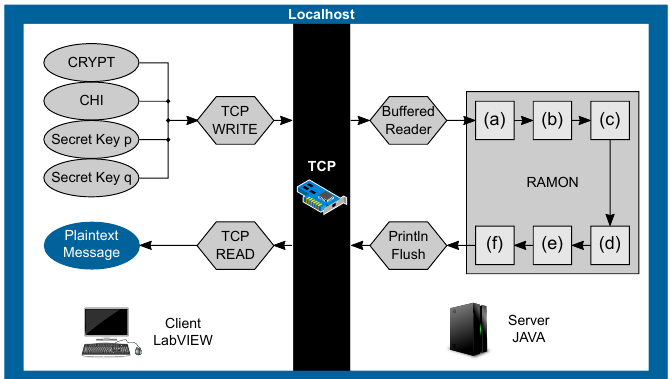
Figure 5. Flow chart of the time-optimized decryption using a TCP/IP connection to interact between LabVIEW and the Java application. CHI, the secret keys p and q and the crypt c ∗ are transferred from LabVIEW to the Java application via a TCP/IP connection. The decryption process is performed in the Java application. It sends back the plain message x to LabVIEW when completed.